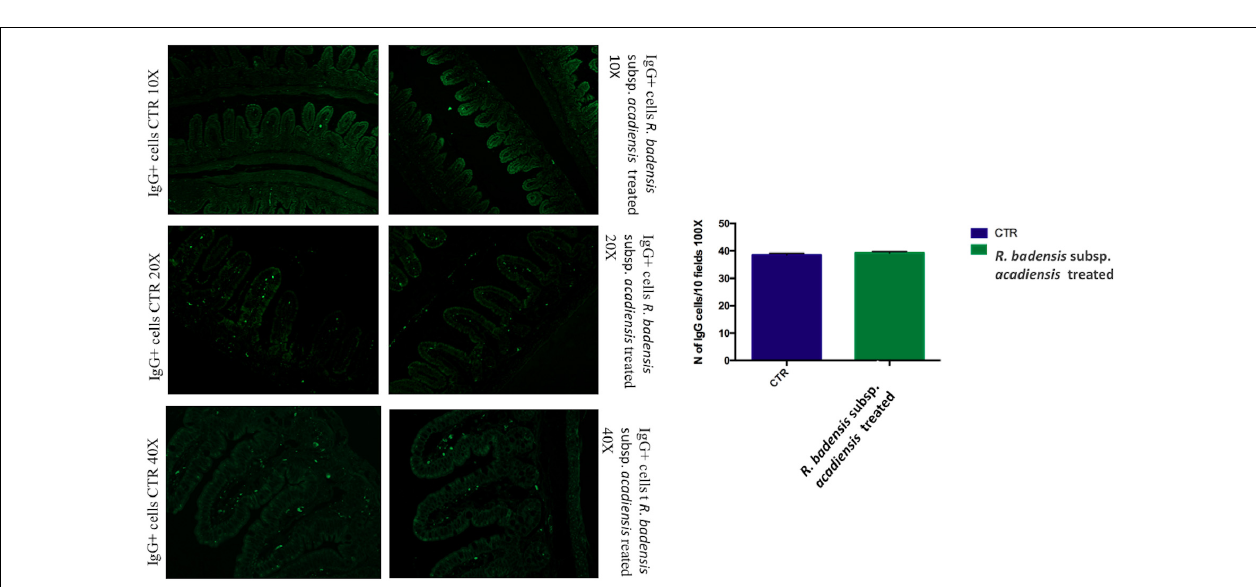
FIGURE 3 | Mean ± SEM of the number of IgA positive cells populations in 10 fields of objective 100X in the ileum of mice fed 1% sucrose (CTR) or R. badensis subsp. acadiensis fed 10 8 CFU/mouse/day for 7 days. Significant difference exists if * p < 0.05, representative tissue photos are taken with 10 × , 20 × , and 40 × magnifications.